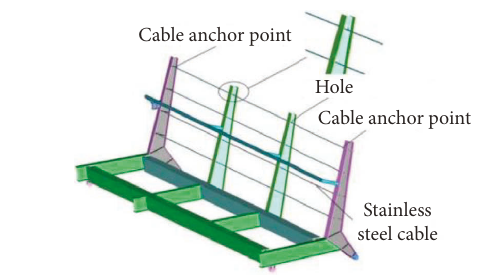
Figure 19: Improved railing.